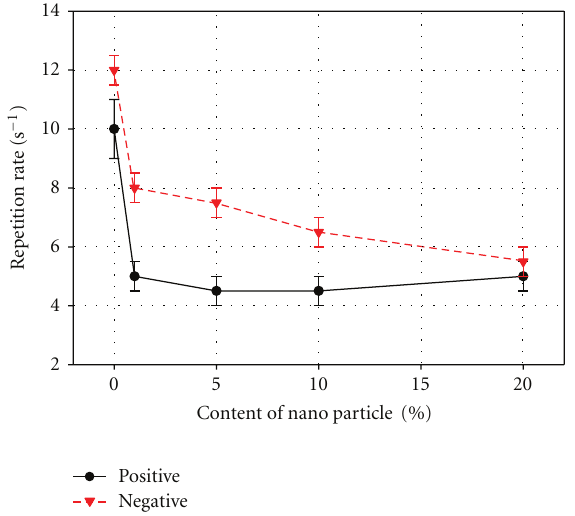
Figure 14: Charge pulse repetition rate of pure epoxy resin and epoxy-based nanocomposites (90% confidence